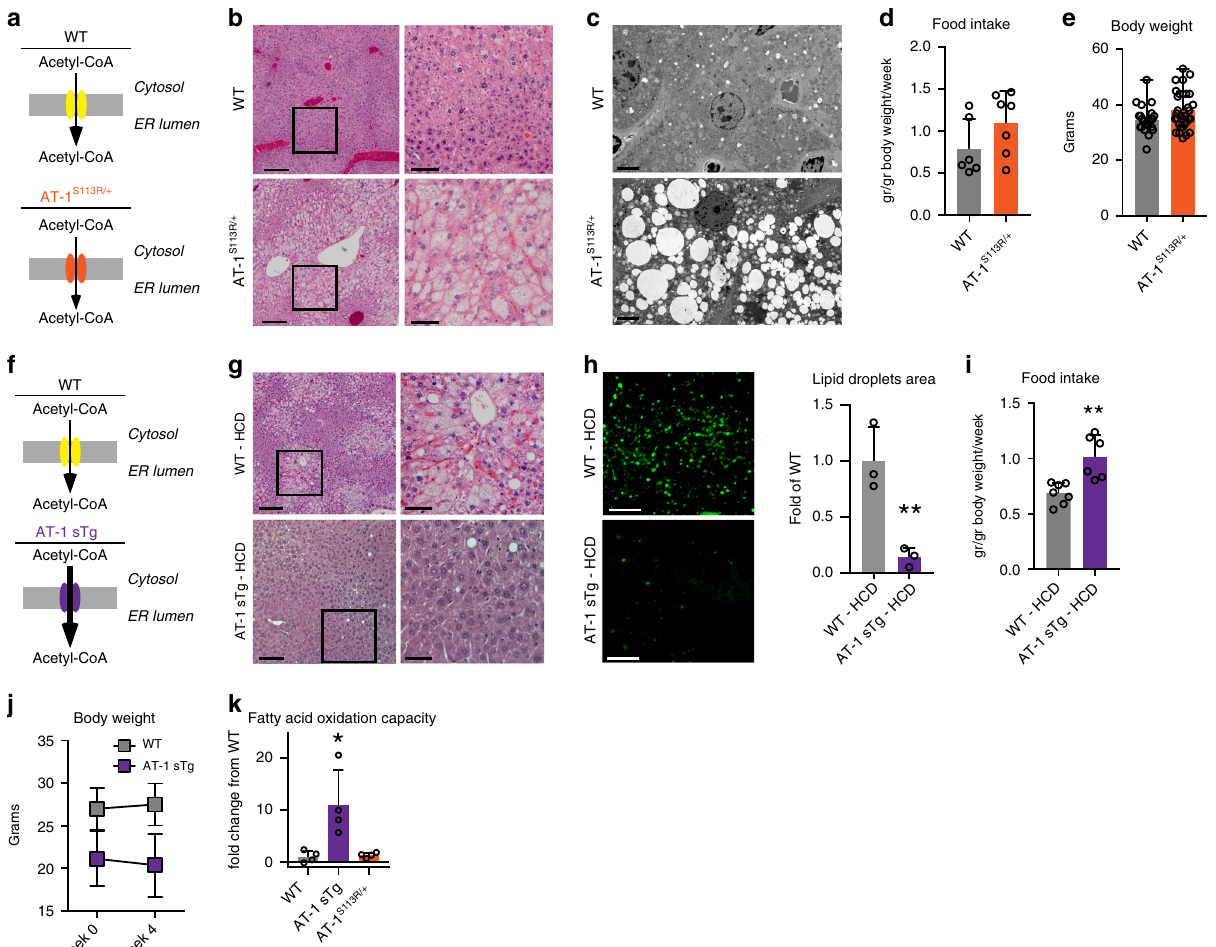
Fig. 1 AT-1 S113R/ + show spontaneous steatosis while AT-1 sTg are resistant to diet-induced steatosis. a Schematic representation of reduced acetyl-CoA transport through AT-1 in the haploinsuf fi cient AT-1 S113R/ + mice. b Representative H&E staining of liver sections from WT and AT-1 S113R/ + mice. Scale bar, 250 µ m (left), 100 µ m (right). c Representative electron microscopy of the liver sections from WT and AT-1 S113R/ + mice. Scale bar, 5 µ m. d Food intake of AT-1 S113R/ + ( n = 6) mice and age-matched WT ( n = 7) littermates. e Body weight of 6-month-old AT-1 S113R/ + ( n = 31) mice and age-matched WT ( n = 23) littermates. f Schematic representation of increased acetyl-CoA transport through AT-1 in systemic overexpression AT-1 sTg mice. g Representative H&E staining of the liver sections from WT and AT-1 sTg fed a high-carb diet (HCD). Scale bar, 250 µ m (left), 100 µ m (right). h LipidTOX green staining of the liver sections of WT and AT-1 sTg mice fed a HCD. Representative images (left panel) and quanti fi cation (right panel) are shown (WT, n = 3; AT-1 sTg, n = 3). Scale bar, 25 µ m. i Food intake of AT-1 sTg ( n = 6) and WT ( n = 7) littermates while fed a high-carb diet. j Body weight of 3-month-old AT-1 sTg ( n = 8) mice and age-matched WT ( n = 8) littermates at week 0 and week 4 of the high-carb diet. k Fatty acid oxidative (FAO) capacity as examined by Seahorse assay in primary cultured hepatocytes (hepatocytes from biologically independent animals; WT, n = 4; AT-1 sTg, n = 4; AT-1 S113R/ + , n = 4). Statistical analysis was performed using a one-tailed Student ’ s t test. * P < 0.05; ** P < 0.005; # P < 0.0005; All data are represented as mean ± s.d. Circles indicate individual animals